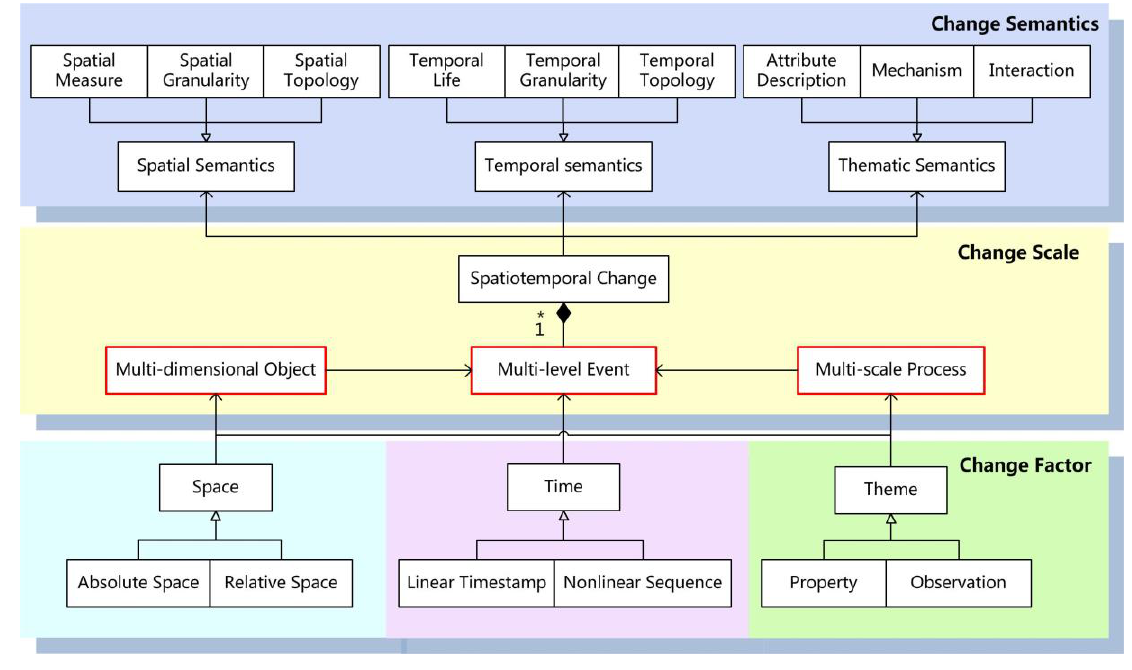
Figure 2. Spatiotemporal Change-oriented Conceptual